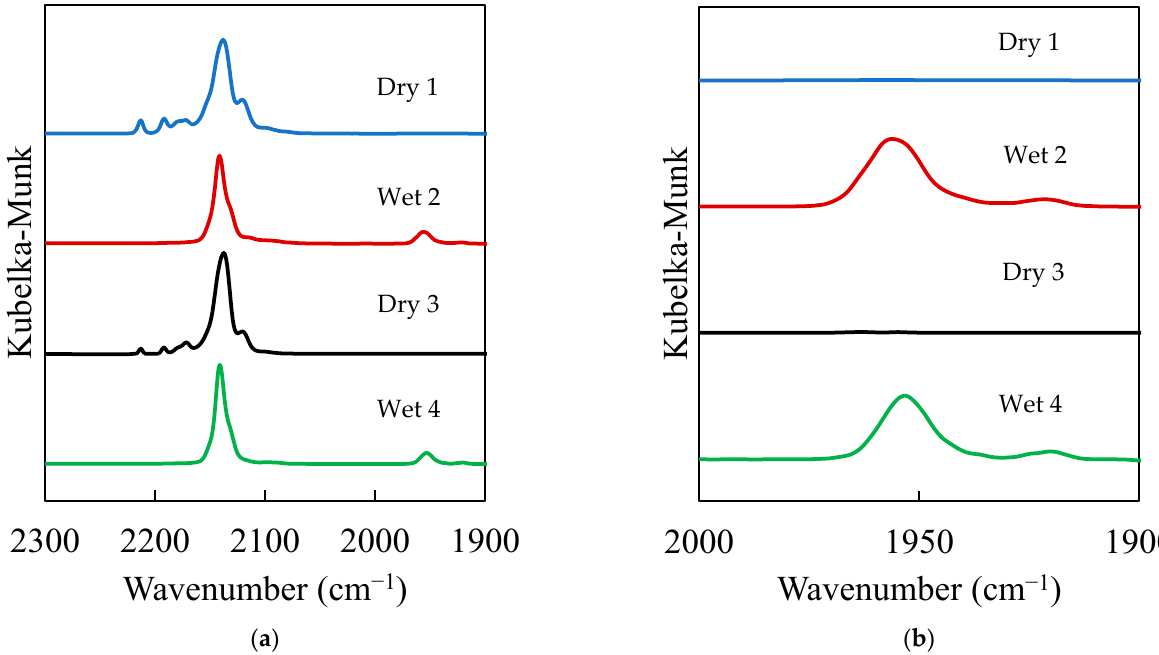
Figure 7. CO DRIFTS at 80 °C with four consecutive experiments switching between dry and wet conditions, with O 2 pretreatments at 500 °C in between each. Exposure time = 30 min. (1000 ppm CO, 2% H 2 O, 10% O 2 , balance He). ( a ) Showing the region depicting ionic and reduced Pd species. ( b ) Zoomed in to the region where CO-Pd 2 peaks arise.